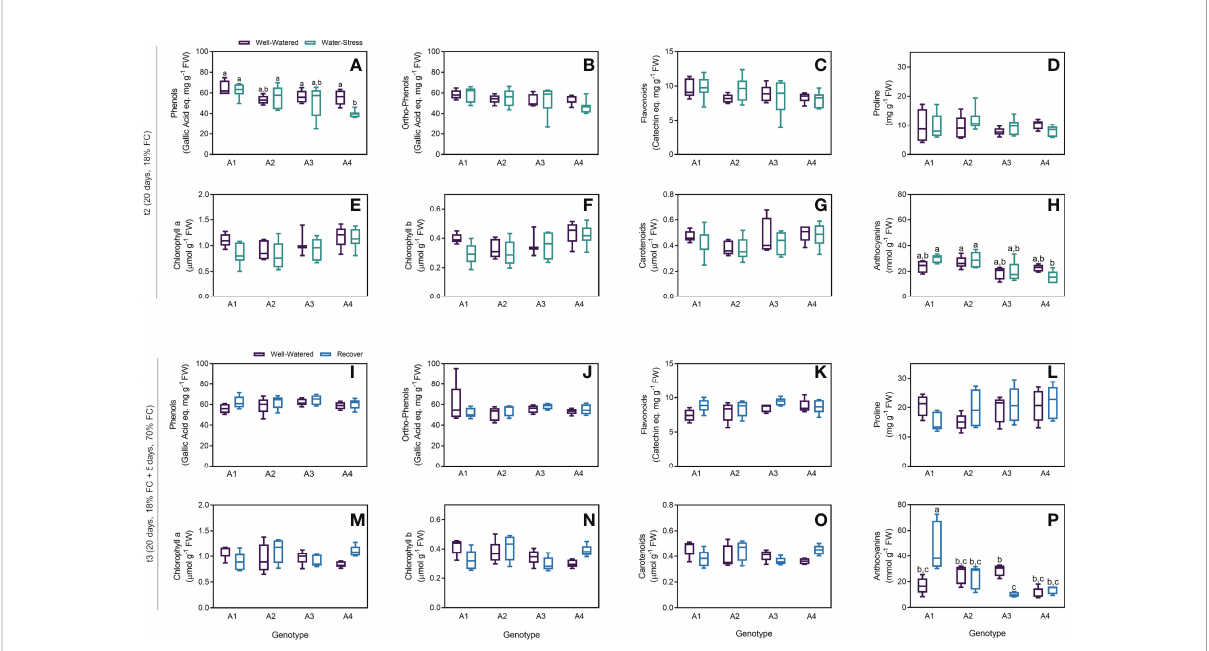
FIGURE 3 Biochemical parameters measured on t2 (20 days) and t3 (20 + 5 days) on 4 genotypes (A1, A2, A3 and A4) and 3 water regimes (well-watered, water-stress and recover): phenols on t2 (A) , ortho-phenols on t2 (B) , fl avonoids on t2 (C) , proline on t2 (D) , chlorophyll a on t2 (E) , chlorophyll b on t2 (F) , carotenoids on t2 (G) and anthocyanins on t2 (H) , phenols on t3 (I) , ortho-phenols on t3 (J) , fl avonoids on t3 (K) , proline on t3 (L) , chlorophyll a on t3 (M) , chlorophyll b on t3 (N) , carotenoids on t3 (O) and anthocyanins on t3 (P) . Means ± SDs, n = 5-7, different letters indicate signi fi cant differences between treatments at P ≤ 0.05, according to a Tukey ’ s multi comparison